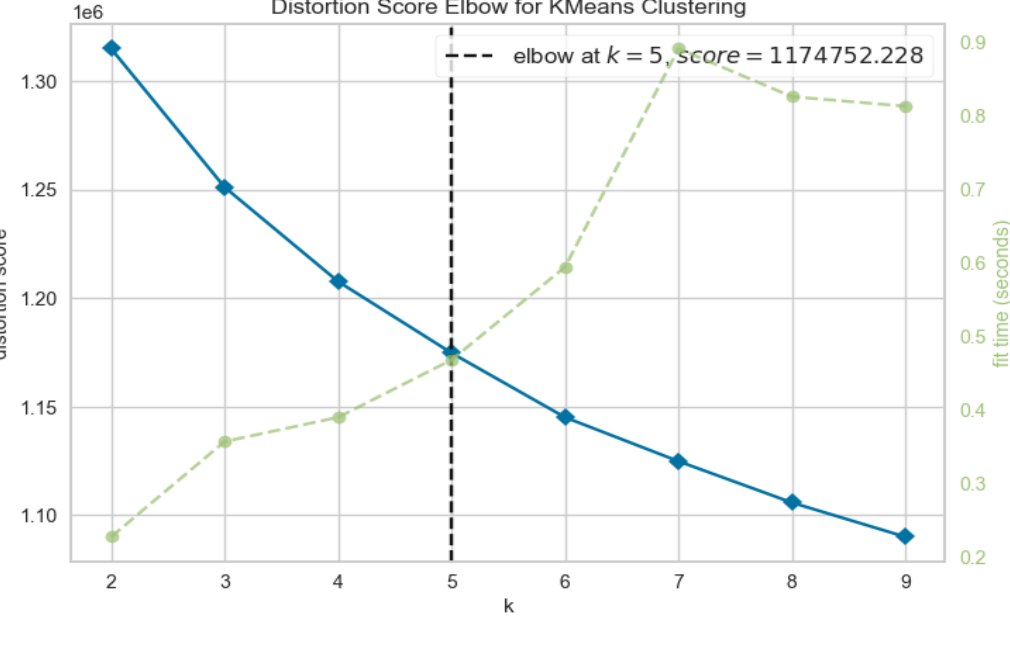
Figure 5. Elbow - method plot. Figure 5. Elbow-method